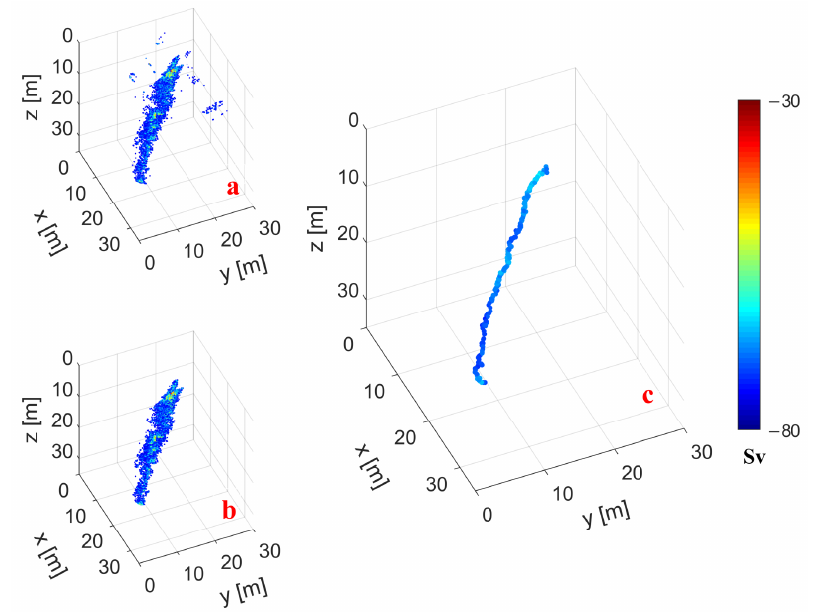
Figure 12. The 3D illustration of the processing steps’ results of the gas leakage flare, where 3D results of the gas leakage flare obtained from ( a ) uncleaned data, ( b ) cleaned data, and ( c ) gas leakage flare spine results calculated by the geometric